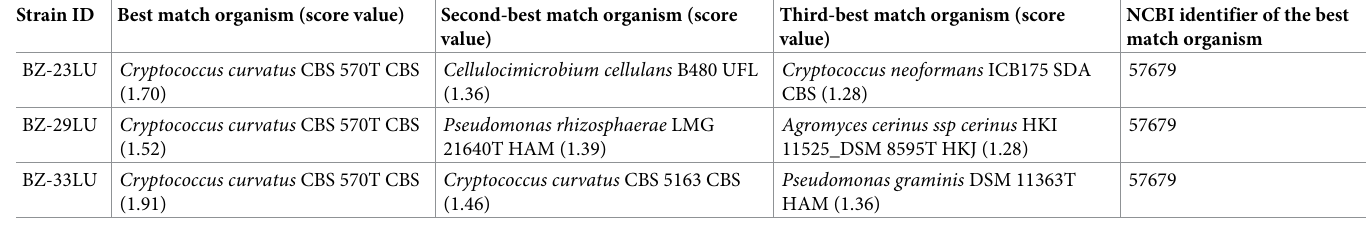
Among NMC severity factors previously described and those considered in the present study, only the poor therapeutic outcome was associated with infections due to the less common MLST STs isolates (ST5, ST659, ST53, ST31, ST4, and ST69) versus the main ST (ST93) (87.5% vs. 40%, respectively; p = 0.02). Table 4 summarizes the NMC severity factors com- pared to the MLST ST of C . neoformans isolates.